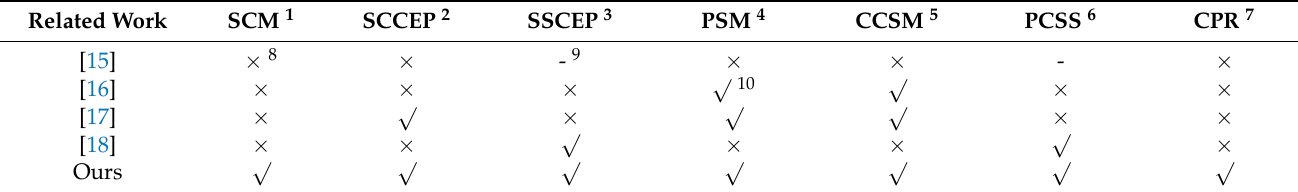
Table 2. Comparison of existing steganography and steganalysis overviews based on VoIP. Related